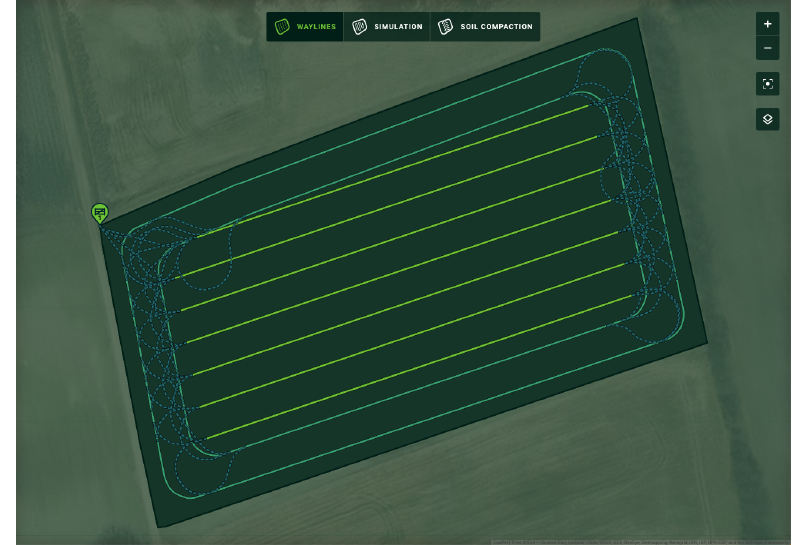
Figure 2. Field partitioning example: Generated waylines and possible